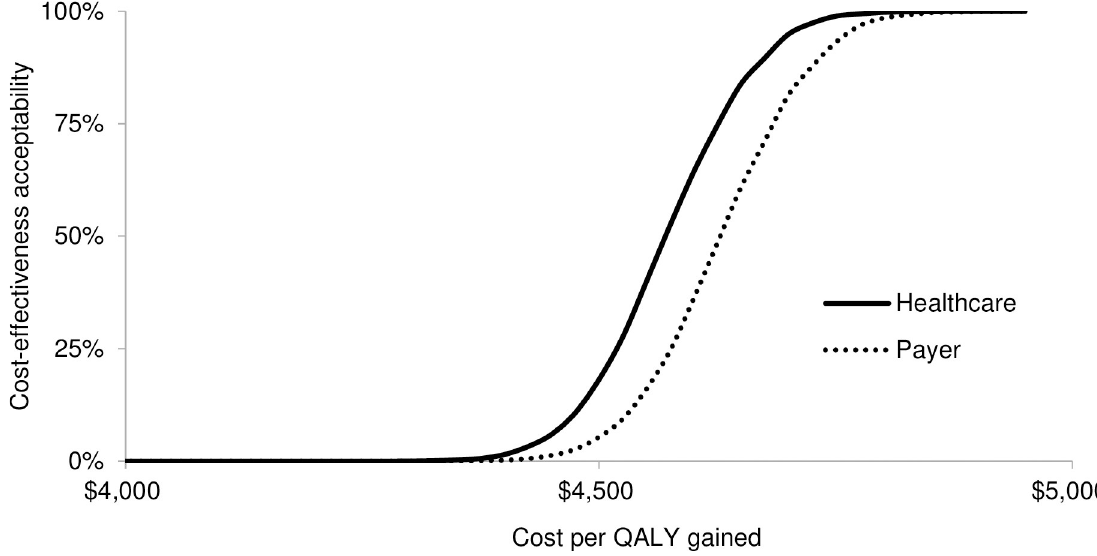
Fig 5. Cost-effectiveness acceptability curves from the healthcare and payer perspective.